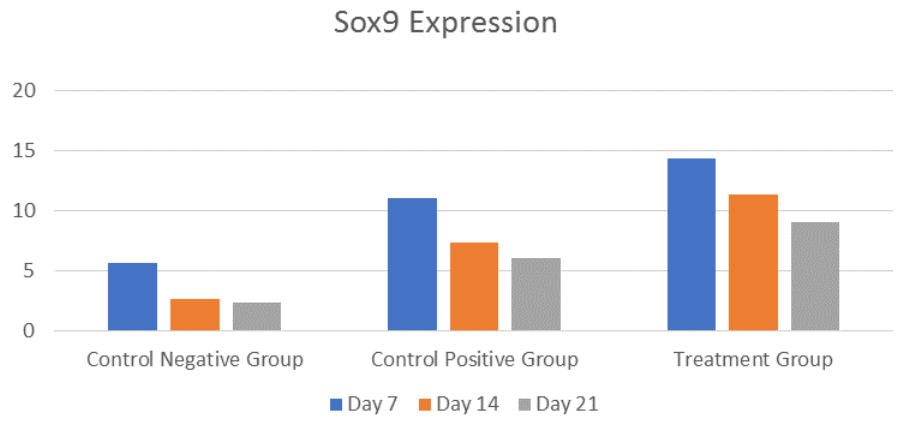
Figure 4. Mean Sox9 expression on Days 7, 14, 21 in each treatment group (n=6).